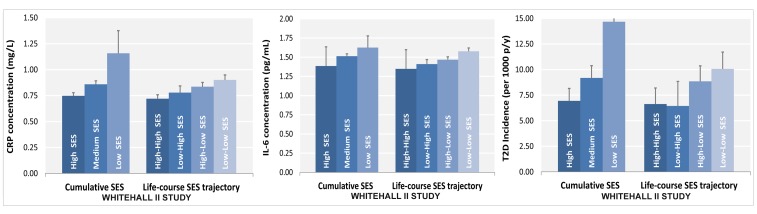
Association of lifecourse socioeconomic status with two inflammatory markers and type 2 diabetes.Lower SES is associated with higher CRP (A) and IL-6 levels (B) and with a greater type 2 diabetes risk (C) after adjustment for sex, age, and ethnicity. All p for linear trend between lifecourse SES and inflammatory markers or type 2 diabetes were <0.001. Cumulative SES score includes father's occupational position, participants' education, and participants' occupational position at phase 3. Each SES measure was a 3-level variable with values ranging from 0 (high) to 2 (low). A score was calculated by summing each SES measure (range 0–6). The final cumulative SES score was categorized as high (score = 0–2), middle (score = 3–5), and low (score = 6). Lifecourse SES trajectory refers to father's occupational position and participants' occupational position at phase 3. p-y, person-years; T2D, type 2 diabetes.